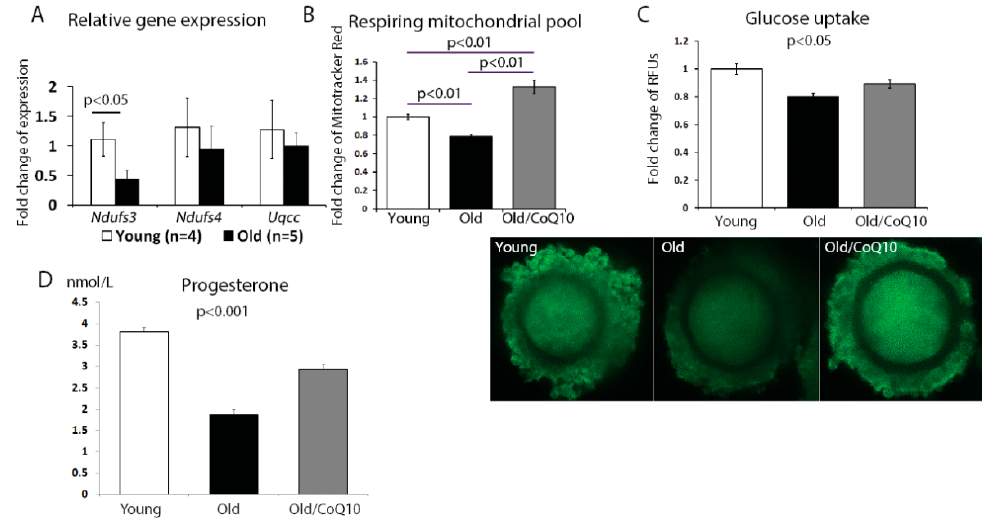
Figure 3. Reduced cumulus cells metabolism function with aging. ( A ) Fold change of the mRNA levels of genes involved in oxidative phosphorylation, with a significant reduction of Ndufs3 expression in cumulus cells from old mice. Data shown were generated from the same samples as those in Figure 1 A. ( B ) Mitotracker Red signal measured in live cumulus cells from a merged pool of cells of numerous oocytes, of at least three females. Aging significantly decreased the mitochondrial respiring pool and CoQ10 supplementation increased the respiring mitochondria. The values are expressed as mean ± SEM of the fold change in fluorescence units per cell, compared to the young group ( n = 192 for young; n = 208 old; and n = 33 for CoQ10, magnification 400 × ). ( C ) Glucose uptake by cumulus cells is reduced with aging, but can be improved by CoQ10 supplementation. Images below demonstrate the cumulus–oocyte complexes at the germinal vesicle stage, stained with florescent glucose (6-NBDP), and are expressed as fold change of random fluorescence units, adjusted to the young group ( n = 65 regions from 20 young cumulus–oocyte complex (COCs), n = 49 regions from 15 COCs for old, and n = 44 regions from 14 COCs from Old/CoQ10; magnification 200 × ). ( D ) Progesterone production is decreased in aged cumulus cells and is restored by in vivo treatment of females with CoQ10. Cumulus cells were pooled from at least three females, for each treatment group, and plated on 96 well plates with n = 18 young, n = 9 for old, and n = 8 for old/CoQ10.